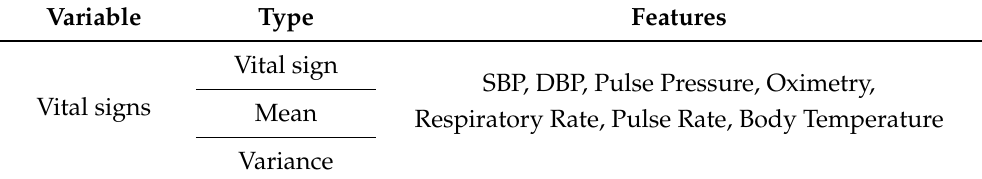
Table 2. Feature Generation.